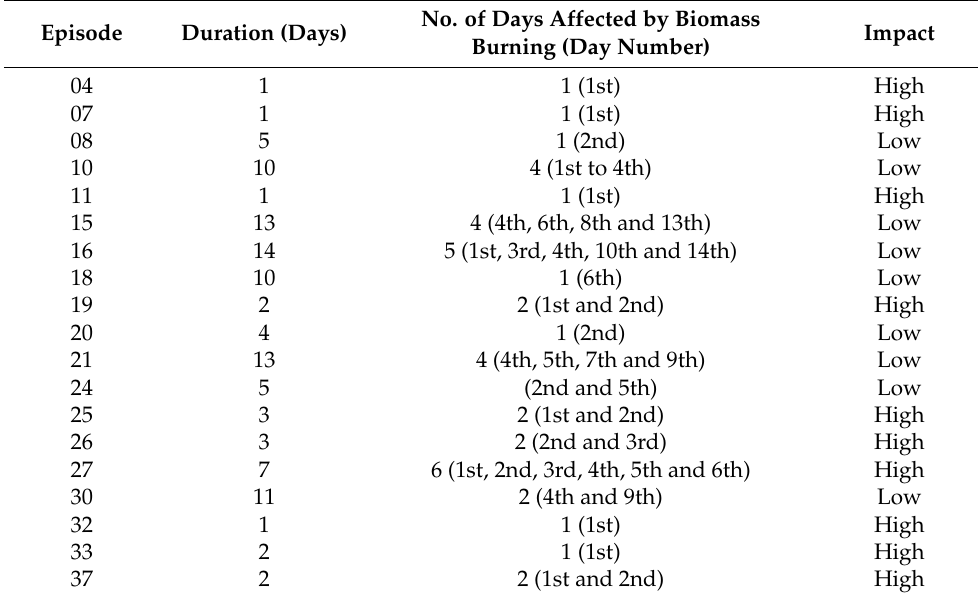
Table 5. Effect of biomass burning on different haze